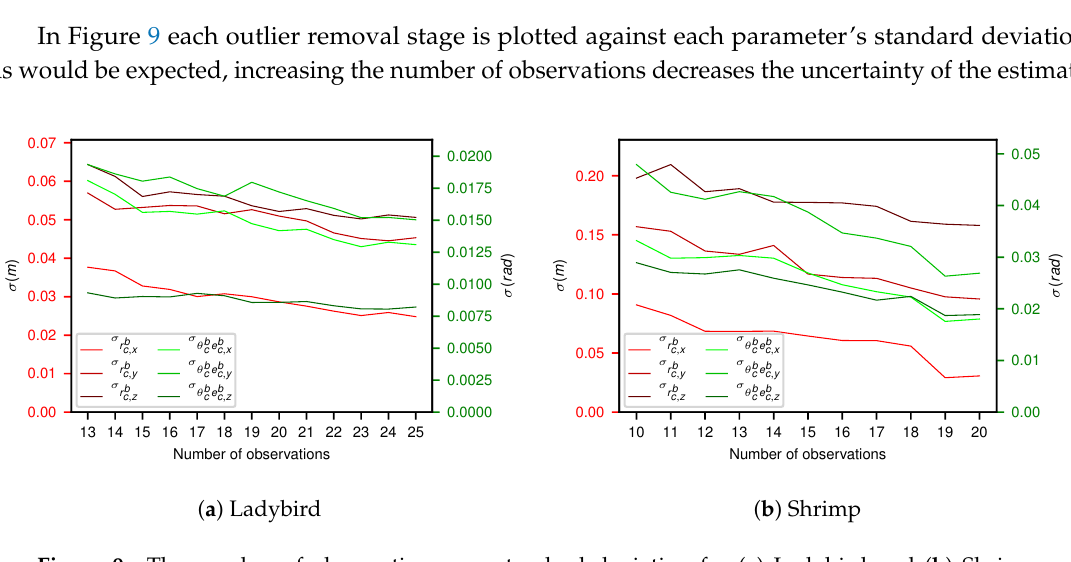
Figure 9. The number of observations vs. standard deviation for ( a ) Ladybird and ( b ) Shrimp respectively. The x axis mirrors the outlier removal stages shown in Figure